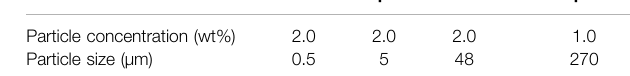
Frontiers in Materials |